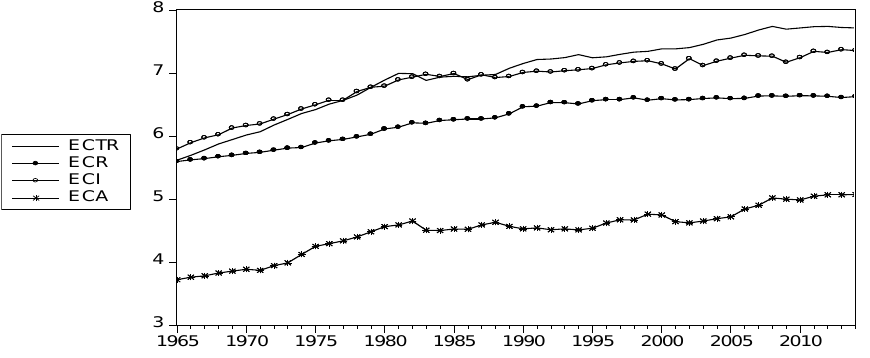
Figure 2. Energy consumption by sectors: the industrial sector (ECI), the transport sector (ECTR), the residential sector (ECR), and the agriculture sector (ECA). Source: Secretary of Energy [24].